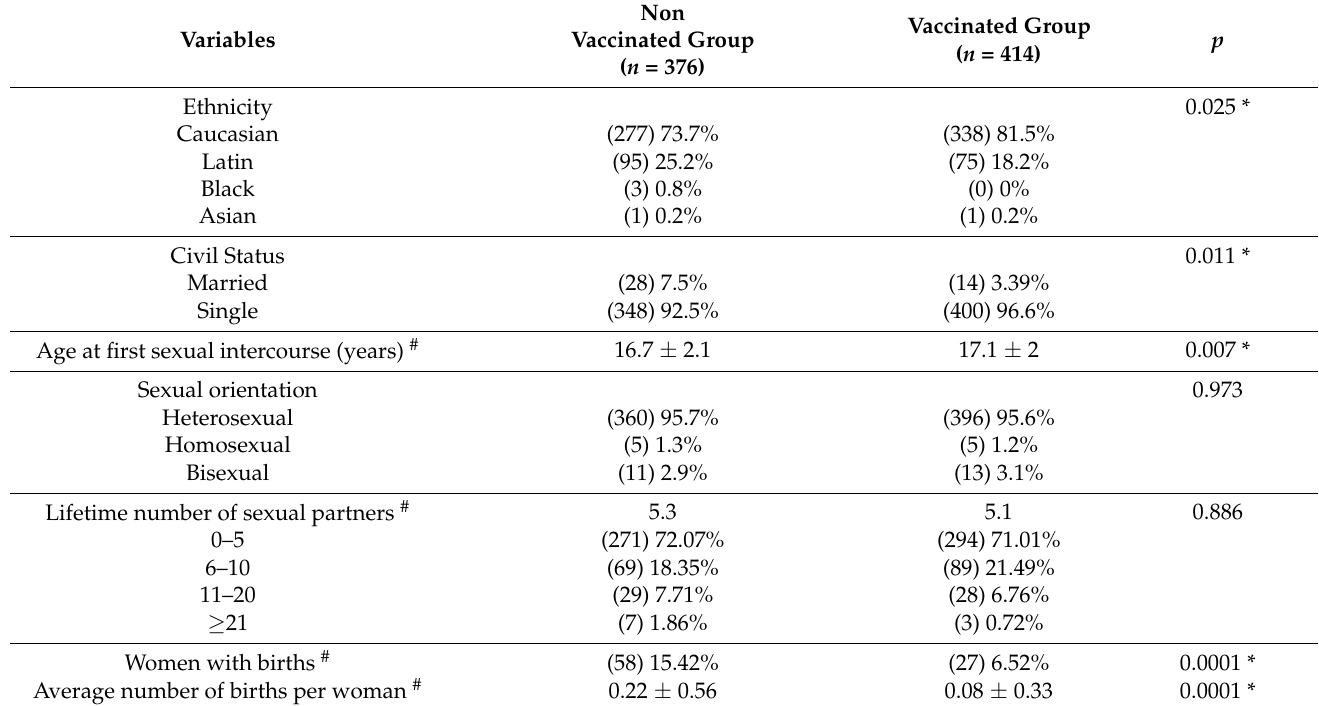
Table 1. Descriptive data of the study participants. * Statistical significance. # Asymmetric distribu- tion. 1 sexually transmitted